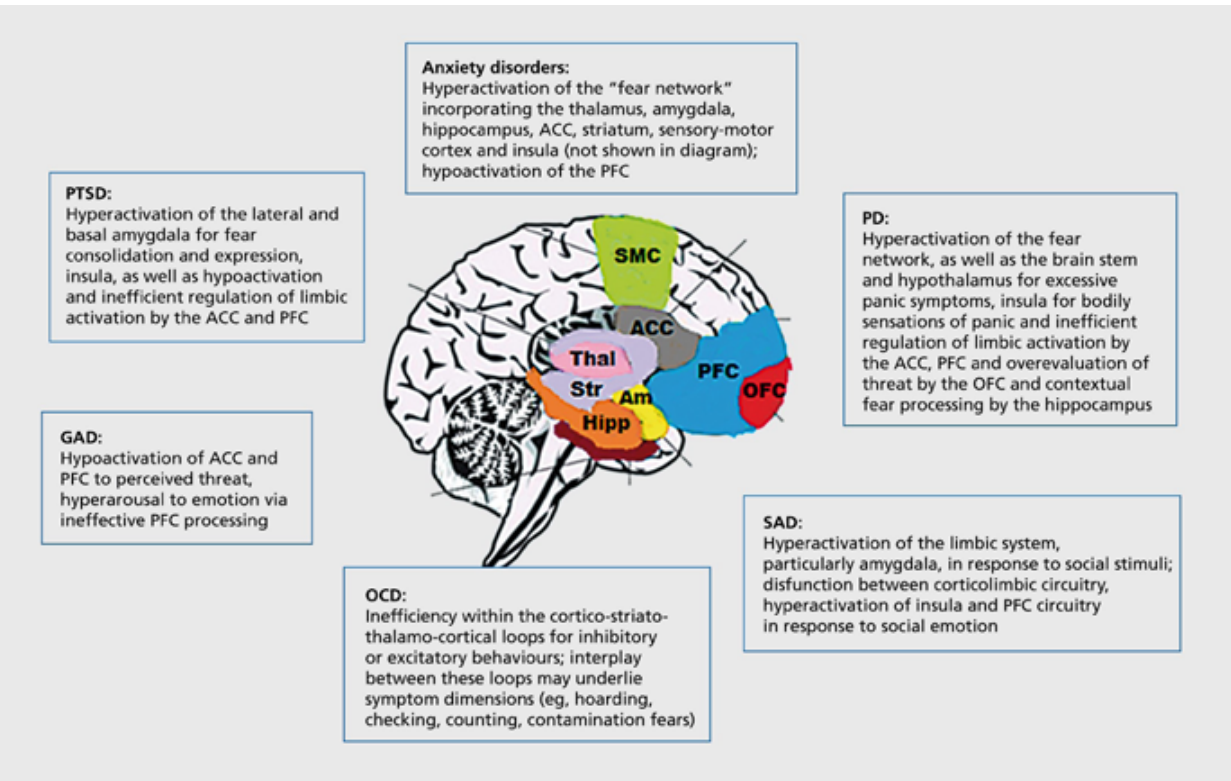
Figure 1: Postulated neural correlates of anxiety and related disorders. PTSD, post-traumatic stress disorder; PD, panic disorder; GAD, generalised anxiety disorder; SAD, social anxiety disorder; OCD, obsessive-compulsive disorder; SMC, sensory-motor cortex; ACC, anterior cingulate cortex; PFC, prefrontal cortex; OFC, orbitofrontal cortex; Thal, thalamus; Str, striatum; Am, amygdala; Hipp, hippocampus